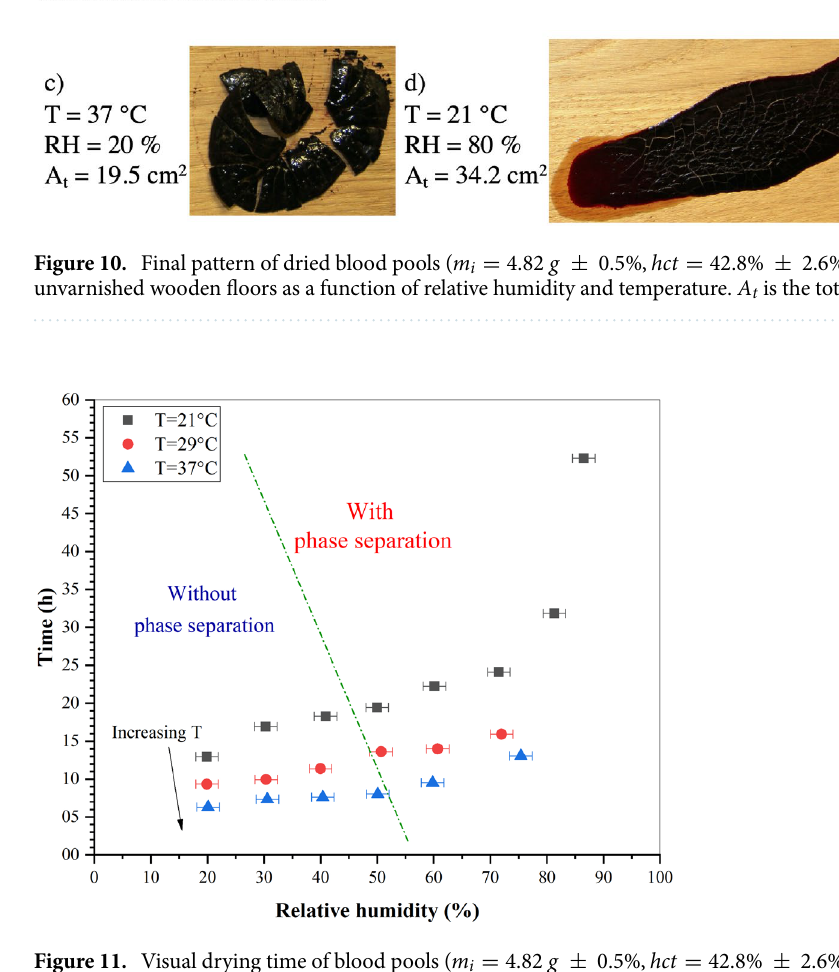
Figure 11. Visual drying time of blood pools ( m i = 4.82 g ± 0.5% , hct = 42.8% ± 2.6% ) on varnished wooden floors as a function of temperature and relative humidity. The green dotted line separates the cases with and without phase separation. (OriginPro